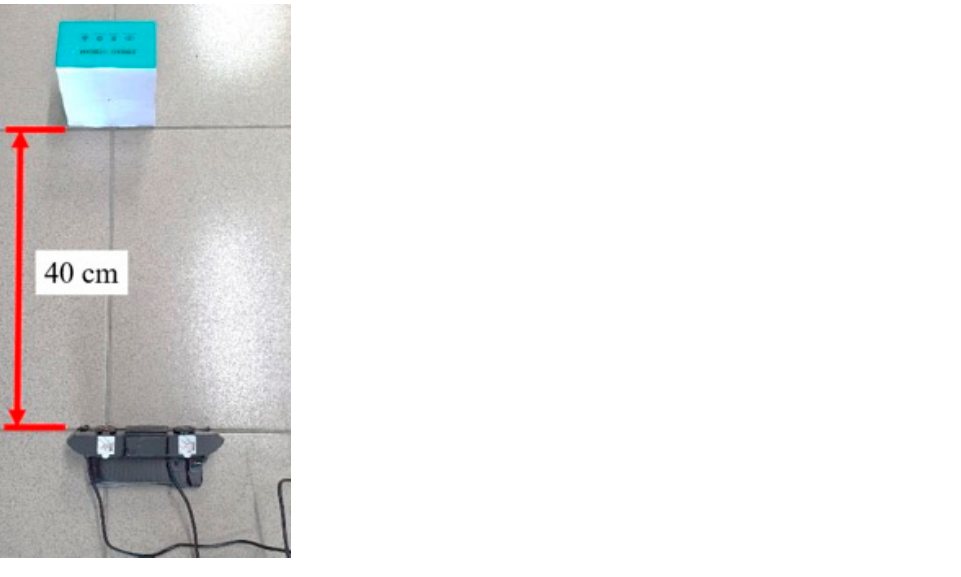
Figure 23. The schematic view of Condition 2, there are 4 measurement points in triggering area. In the first experiment, Condition 1 provided the measuring method, and the results of measurement errors were recorded in Figure 24, corresponding to the Z-axis distance ranging from 20 to 80 cm. When the Z-axis distance ranges from 20 to 35 cm, the error is obviously large. Until the Z-axis reaches farther than 80 cm, the error starts to rise again, but negatively. Figure 25 clearly indicates that the best working distance of this binocular camera is from 35 to 75 cm, within which the absolute values of average, maximum, and minimum errors are 0.22 cm, 0.42 cm, and 0.02 cm, respectively. Figure 24. Z-axis error vs. Z-axis distance diagram (20 to 80 cm). -5051015 15 20 25 30 35 40 45 50 55 60 65 70 75 80 85 Z - a x i s e rr o r ( c m ) Actual Z-axis distance (cm)Z-axis error (20 to 80 cm)